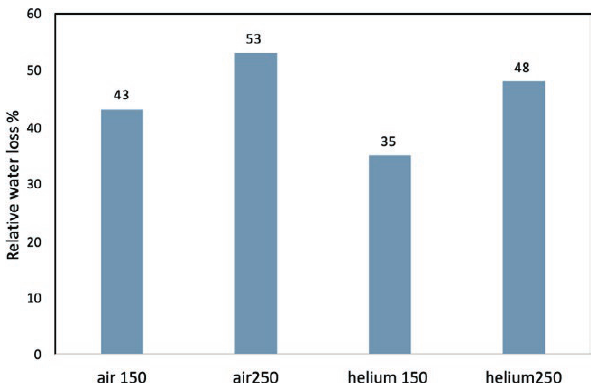
Figure 5. Comparison of the water loss% using air vs helium at 150 °C and 250 °C. Note that the